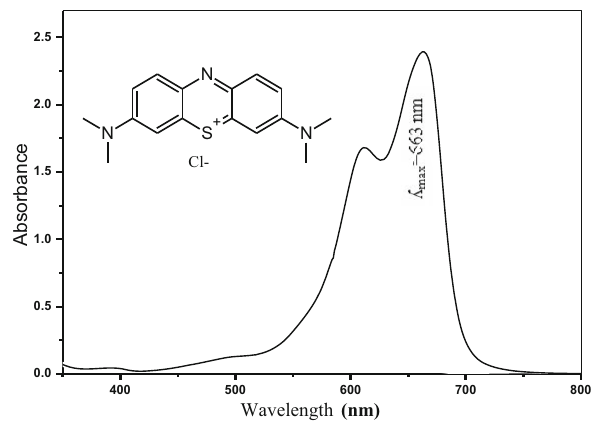
Fig. 1 Molecular formula and UV–Visible spectrum of